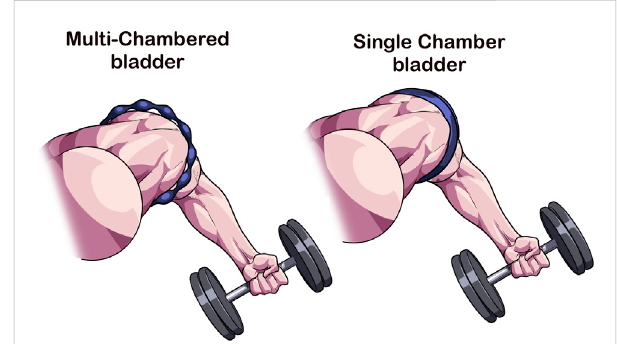
FIGURE 1 Multi-chambered versus single-chambered bladder cuff